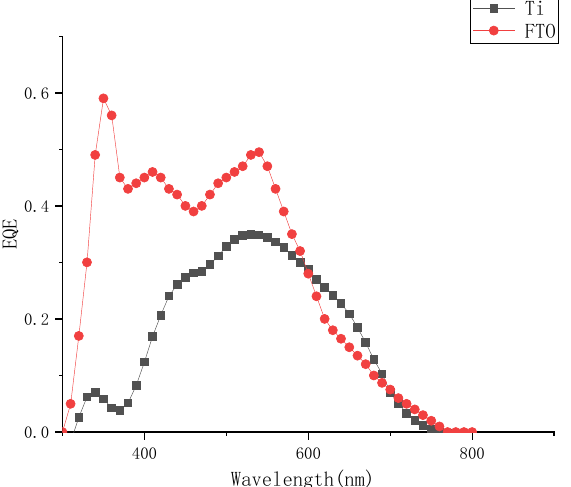
Figure 6. External quantum efficiency curve of different solar cells when the concentration of I 2 was 0.05 M.